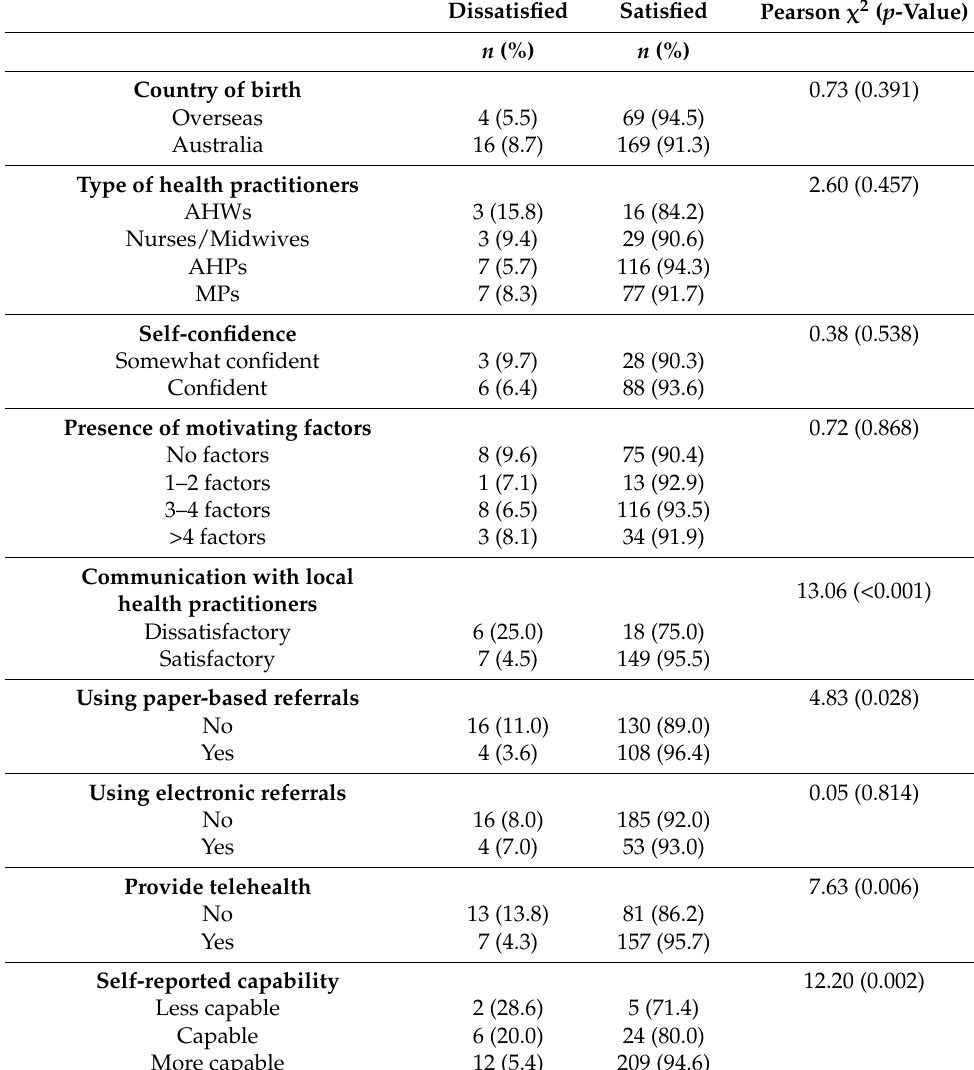
Table 3. Factors associated with outreach health practitioners’ level of